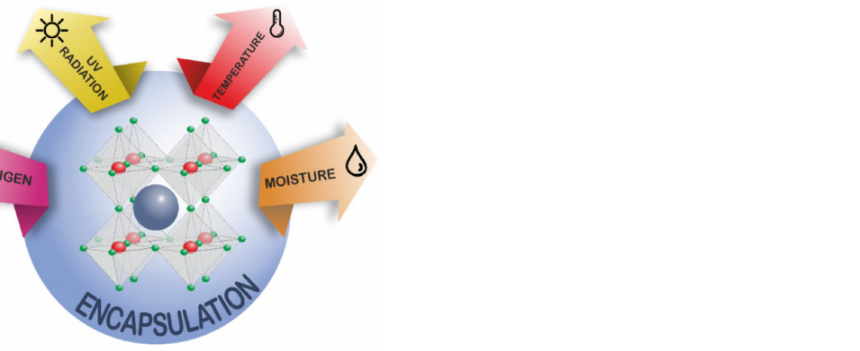
Figure 1. Schematic representation of different factors affecting the stability of perovskite solar